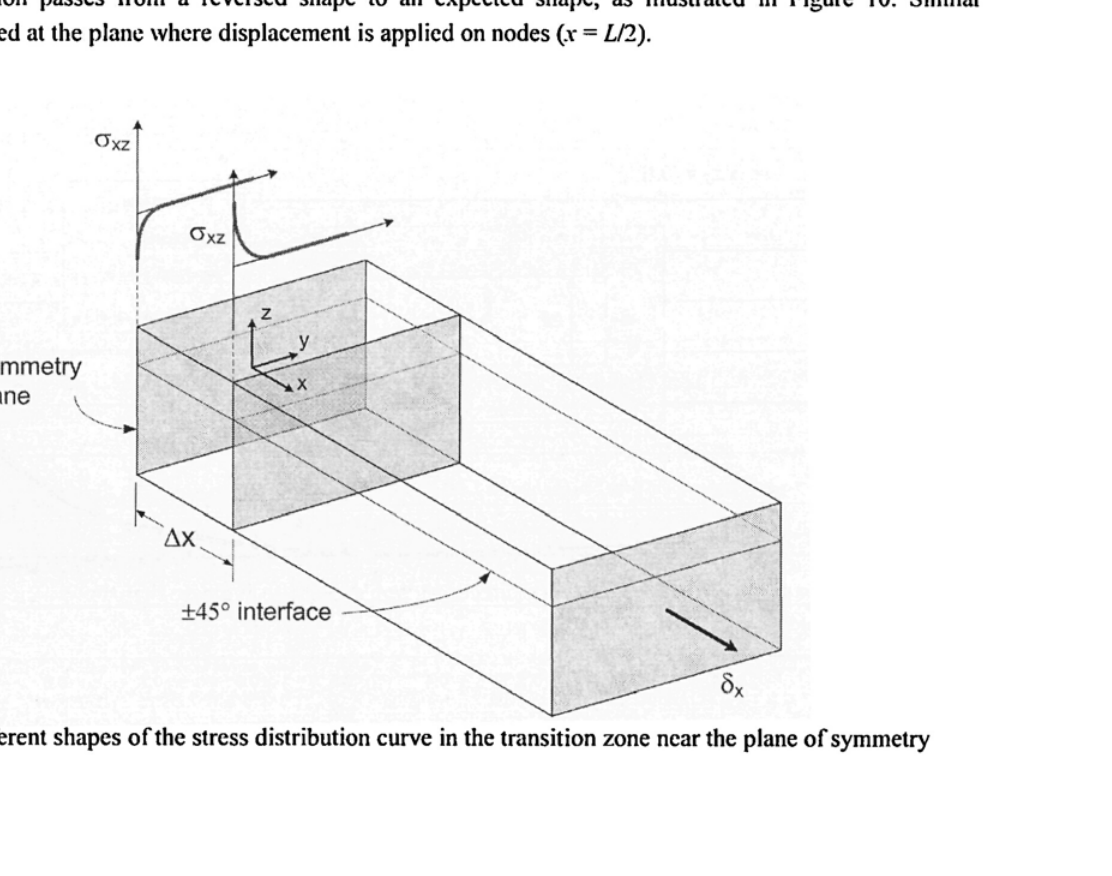
Fig. 10: Two different shapes of the stress distribution curve in the transition zone near the plane of symmetry